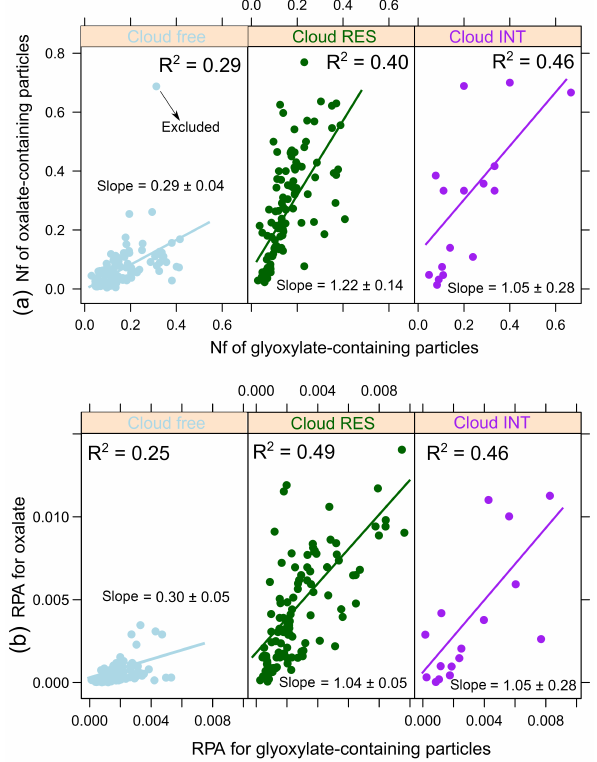
Figure 5. Simple linear regression (with least-square method) be- tween (a) the Nfs and (b) the RPAs of the oxalate-containing and glyoxylate-containing particles, separated for the cloud-free ( N = 109), cloud RES ( N = 107), and cloud INT ( N = 16) parti-